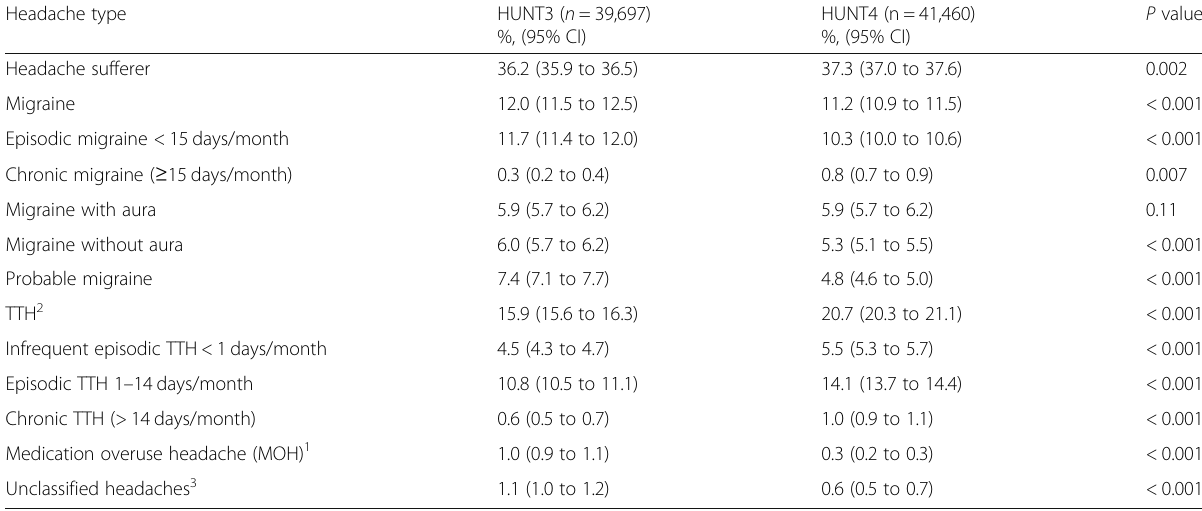
Table 2 Age-and sex adjusted 1-year prevalence of different headache types 1 in HUNT3 and HUNT4 Headache type